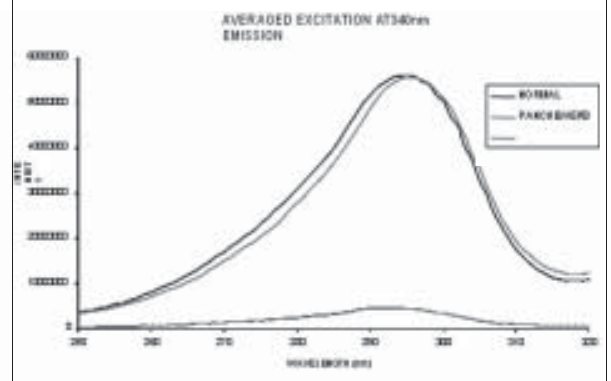
Fig. 3 - Averaged fluorescence excitation spectra of normal, pan